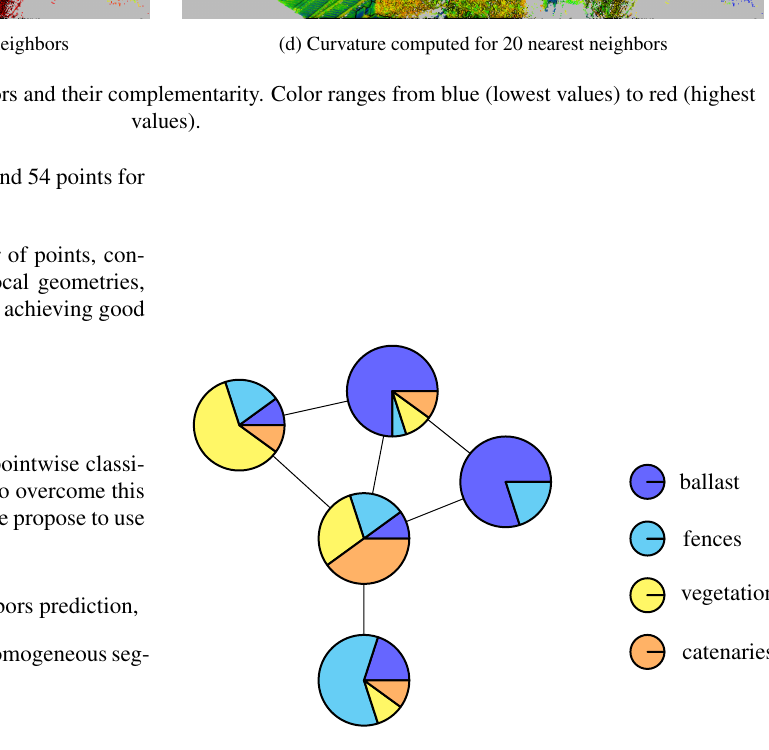
Figure 2. Illustration of the classification of the segments, based on the sum of point’s classifications probabilities. Each pie corresponds to a single segment, and the adjacency relationship illustrates the segment-graph. Each color represents a different class. In our pipeline, the most represented color in a single segment will be associated to every point of the